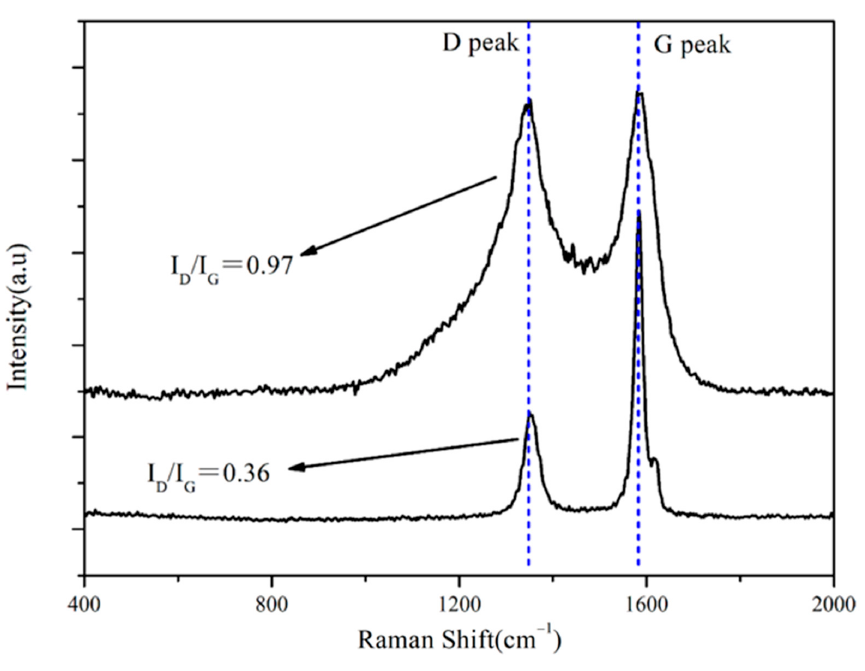
Figure 3. Raman analysis for G10.